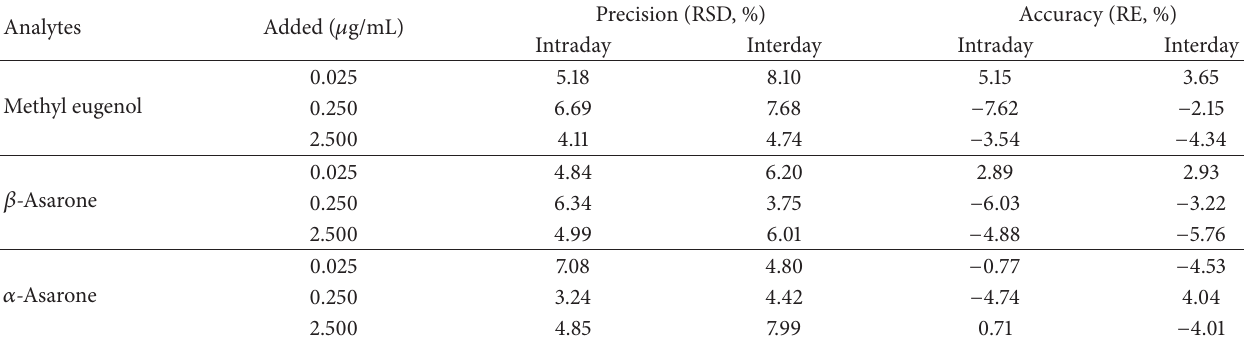
Table 2: Intraday ( 𝑛 = 6 ) and interday precision ( 𝑛 = 5 ) and accuracy of analytes from biological samples. Analytes